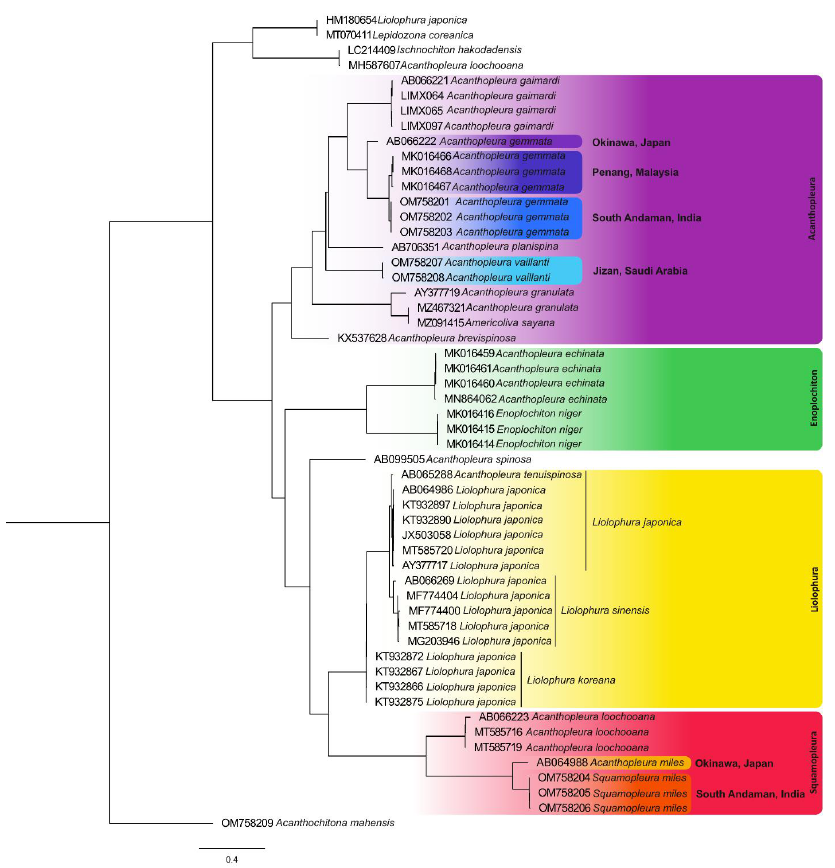
Figure 1. Phylogenetic tree of Acanthopleurinae chitons constructed using cytochrome oxidase c subunit I. The results of the present analysis also provide insights into the biogeography of Ac- anthopleurinae chitons. The majority of species in our study are from the Indo-Pacific re- gion. All the species in the clade ‘Acanthopleura’ are recorded from the Indo-Pacific ex- cept Acanthopleura granulata (Gmelin, 1791), which is recorded from the Caribbean. The clades ‘Liolophura’ and ‘Squamopleura’ include species from the Indo-Pacific, while the species of the clade ‘Enoplochiton’ are restricted along the west coast of South America (Figure 2).